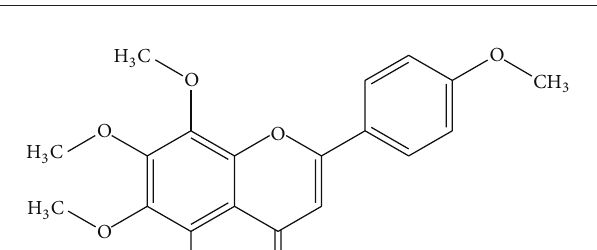
Figure 1: 5-Hydroxy-6,7,8,4 󸀠 -tetramethoxyflavone.